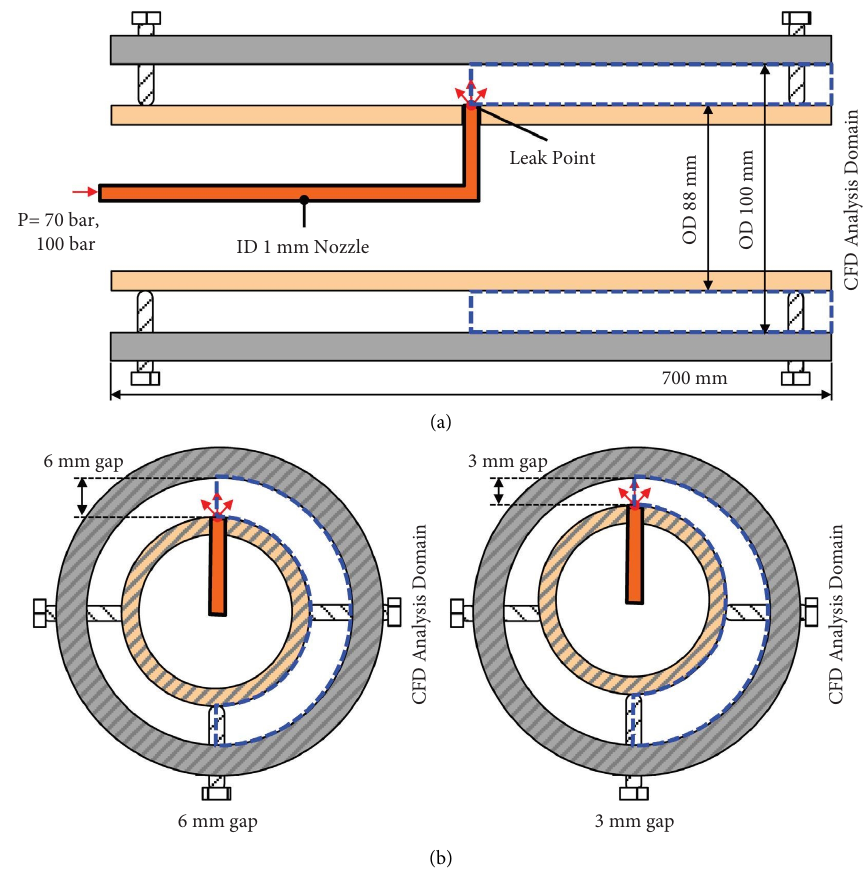
Figure 5: Schematic of the jet experiment: (a) front-view and (b) side-view.